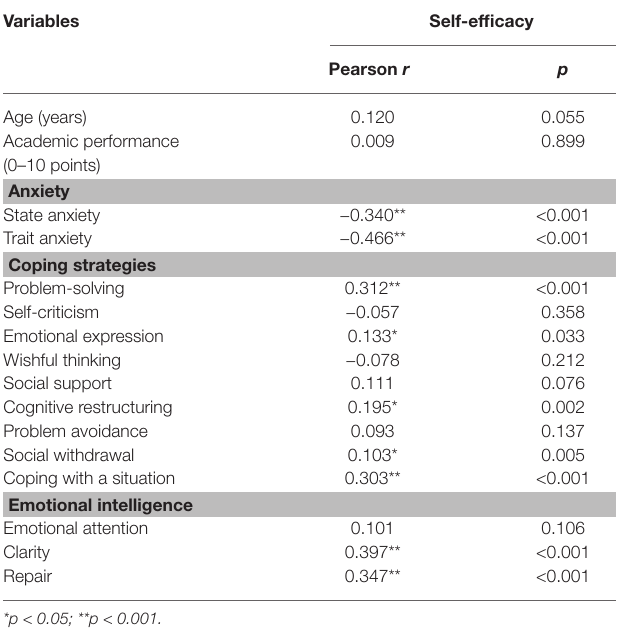
TABLE 2 | Bivariate Pearson correlation between perceived self-efficacy and other independent variables (academic performance, anxiety, coping strategies, emotional